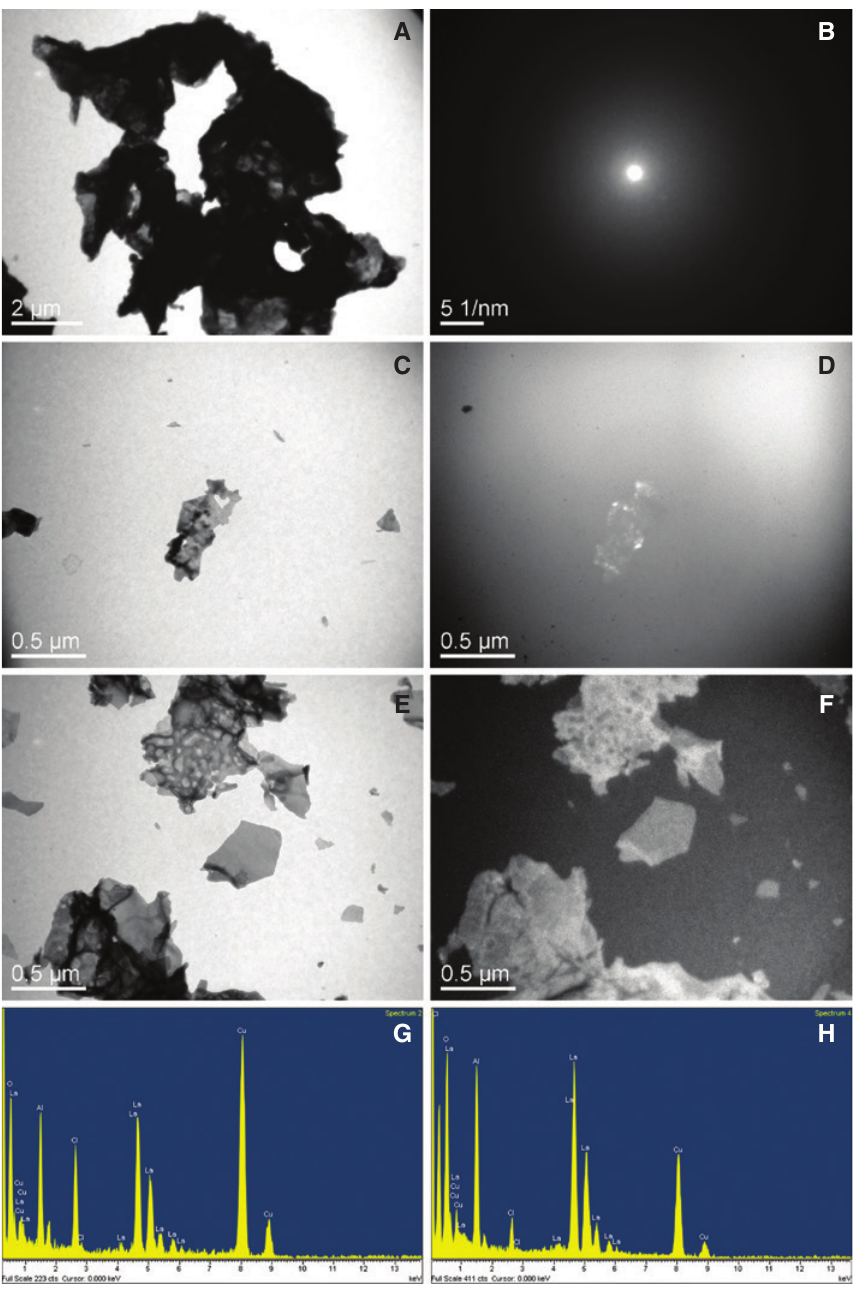
O , micro crystalline LaOCl, Al 2 3